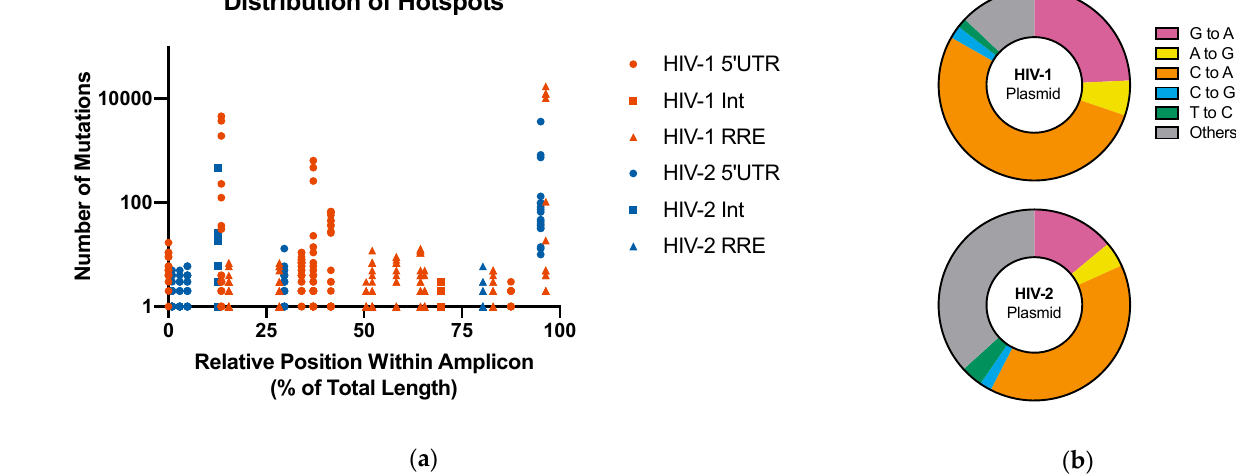
Figure 4. Analyses of background mutations in the MDS pipeline. ( a ) Distribution of plasmid mutation hotspots. The distribution of plasmid hotspots across ROIs was visualized by plotting the relative position of hotspots within the amplicon. A total of 23 sites across the 6 ROIs examined were determined to be hotspots. These occurred all across the amplicon and were not localized to the ends of the ROIs as may be expected due to artifactual errors. Mutation hotspots were dominated by transversion mutations, namely T-to-G mutations in HIV-1 samples (70.2%) and T-to-A mutations in HIV-2 samples (75.7%); ( b ) Relative frequency of background mutation types. Shown are pie charts depicting the frequency of mutation types of interest within the HIV-1 and HIV-2 plasmid samples, which were used as negative control to estimate the frequency and spectra of background errors. The frequency of background errors was 5.84 × 10 − 6 mut/bp in HIV-1 and 9.78 × 10 − 6 mut/bp in HIV-2 samples. The most frequently observed mutations in both plasmids were C-to-A mutations, which accounted for 53.1% and 39.3% of mutations in HIV-1 and HIV-2 plasmid samples, respectively. Mutations commonly associated with Illumina sequencing (e.g., A-to-G, C-to-G, and T-to-C mutations) were observed infrequently.